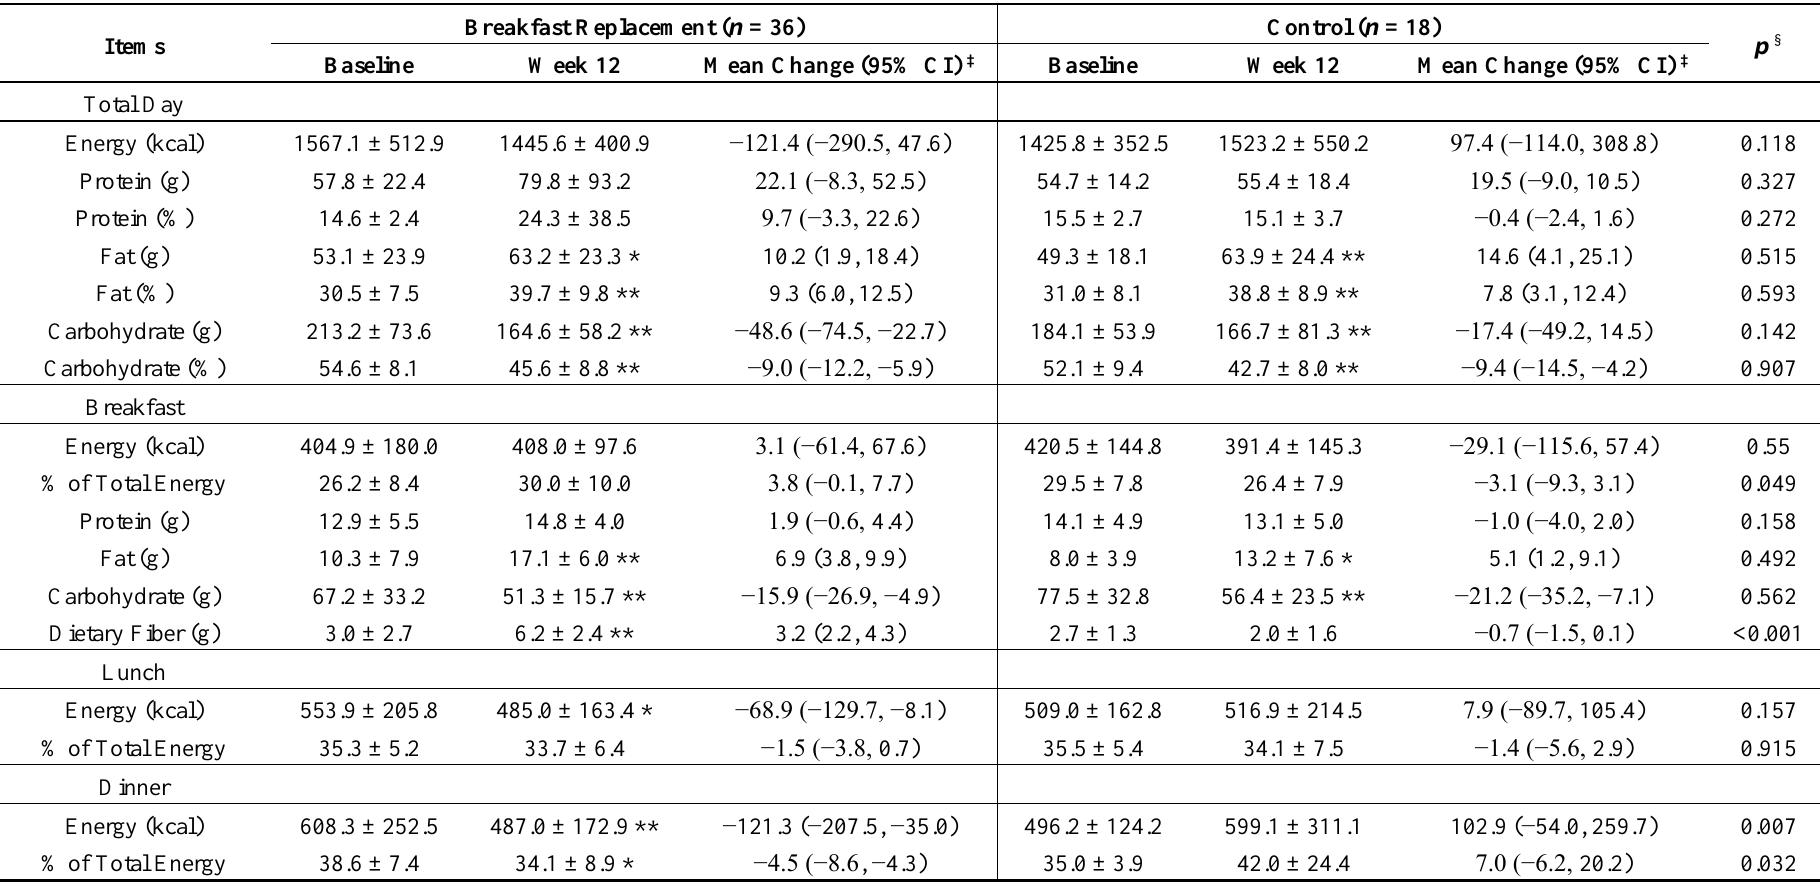
Table 2. Dietary intake of control and treatment groups at baseline and week 12 † (Mean ±